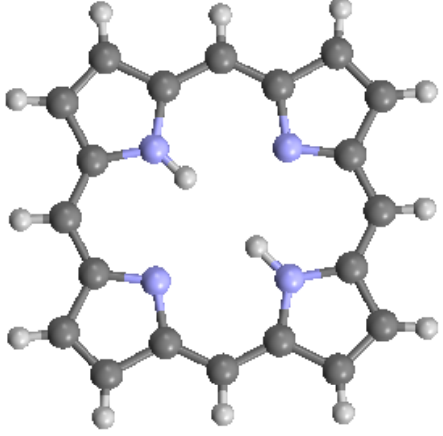
Figure 1. The structure of porphine, from data of [7,9]. Dark gray = C, light blue = N, white = H. (Note: This is the color scheme used from here on, unless otherwise described).